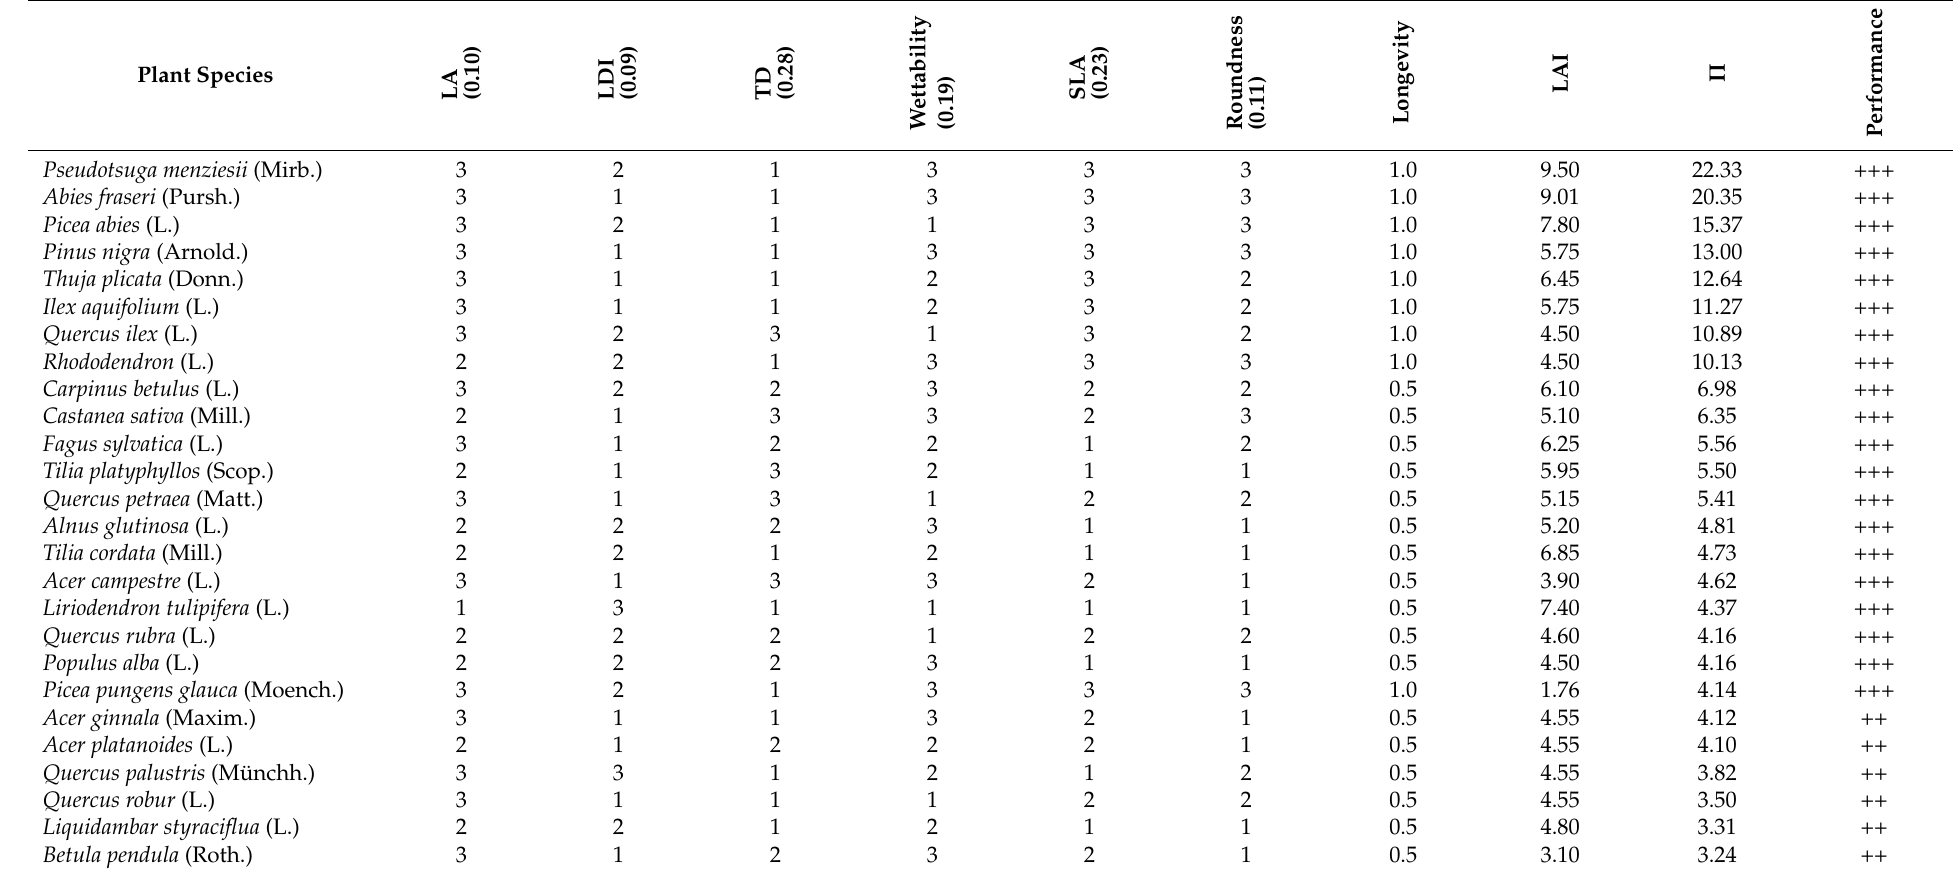
Table 3. Leaf traits model with the assignment of scores (1–3) and weights indicated in parenthesis (W) under each leaf trait to estimate the weighted average based on single leaf area (LA: cm − 2 ), leaf dissection index (LDI: dimensionless), trichome density (TD: mm − 2 ), wettability of leaves (drop contact angles expressed